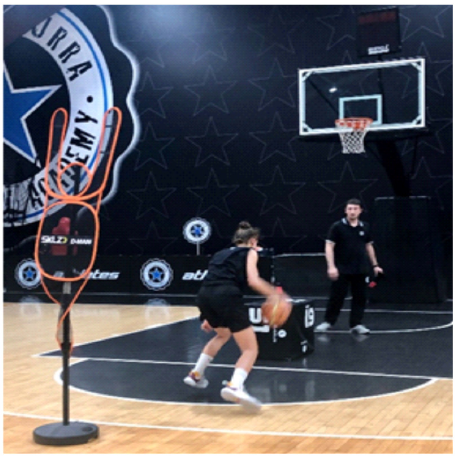
Figure 1. Standard individual training session with the coach. For males, #7 standard National Basketball Association (NBA) and International Bas ‐ ketball Federation (FIBA) balls were used (75–78 cm circumference, 567–650 g weight). For females, the FIBA and WBNA regulation ball size #6 was used (72–74 cm circumfer ‐ ence and 500–540 g